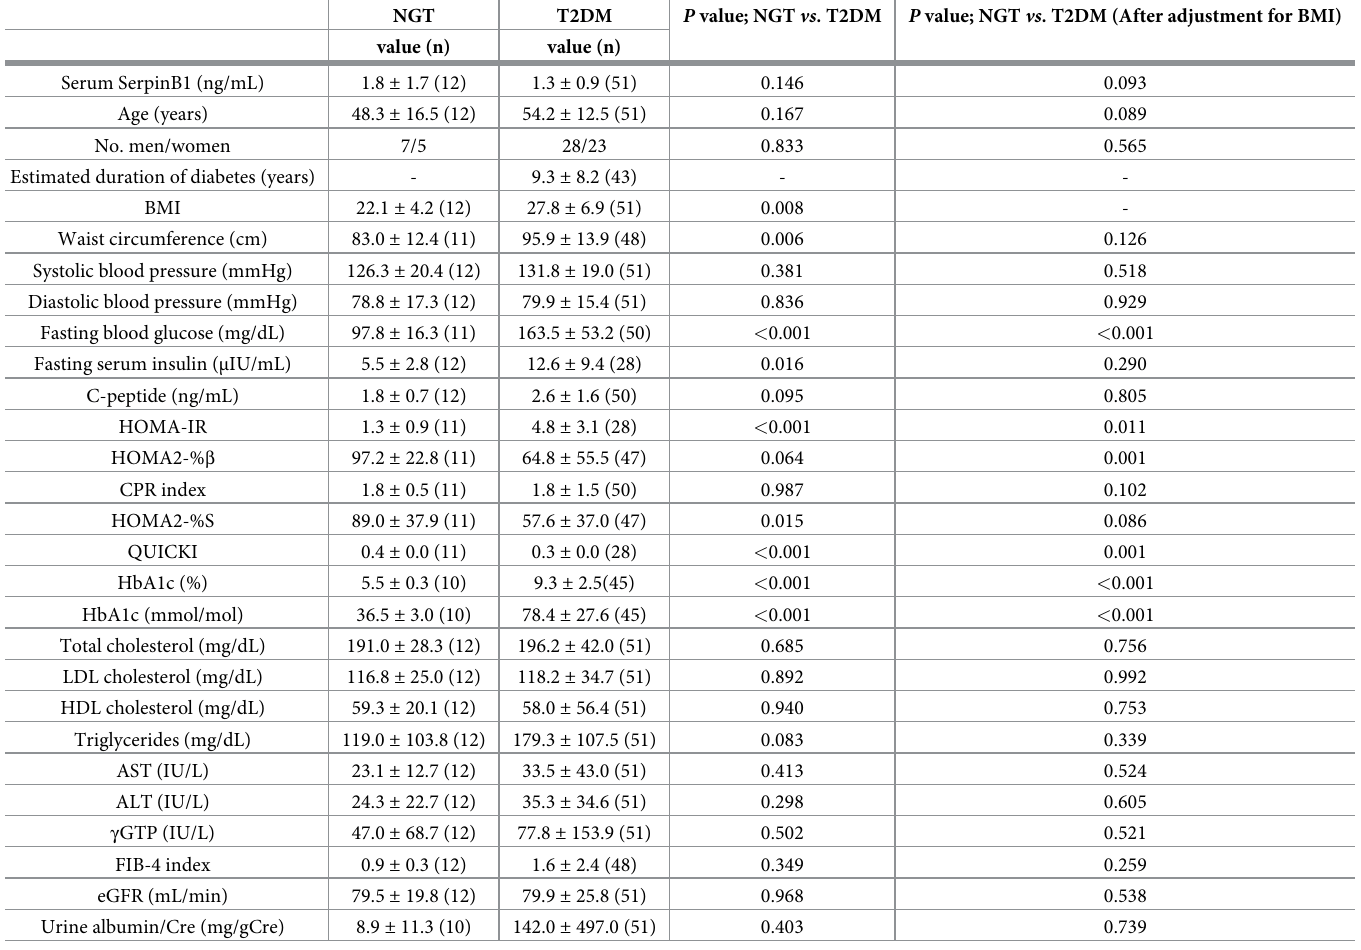
Table 1. Serum SerpinB1 levels and metabolic characteristics of T2DM and NGT